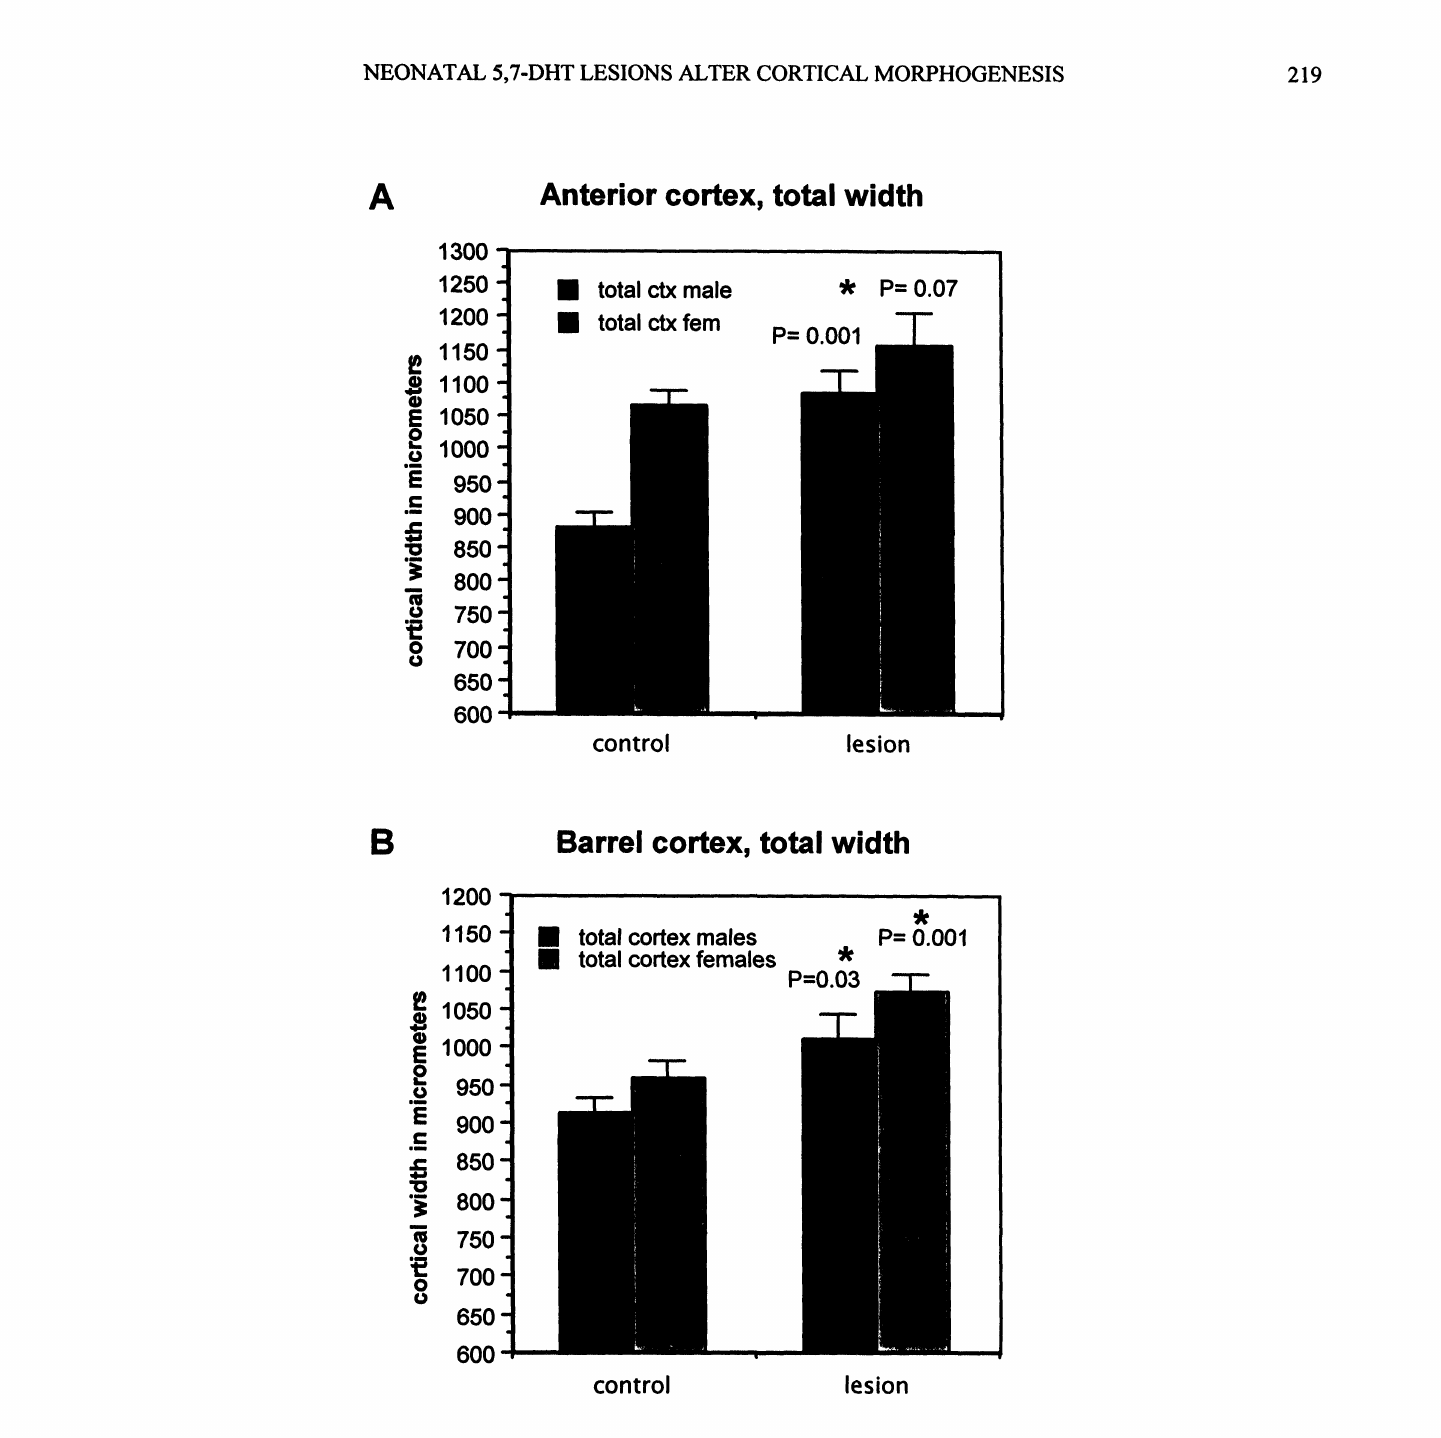
Fig. 2: Comparison of significant changes in total cortical width in anterior (a) and barrel field cortex (b) following bilateral neonatal 5,7-DHT injections; * denotes significant lesion related differences. In anterior cortex, only males displayed significant increases in cortical width, with females nevertheless displaying a strong trend in the same direction. In contrast, in barrel cortex, both males and females show significant differences that are more robust in the female in this region. Note the considerable sex difference in cortical width in control animals (significant in anterior cortex, see text) and their attenuation following the lesion in anterior